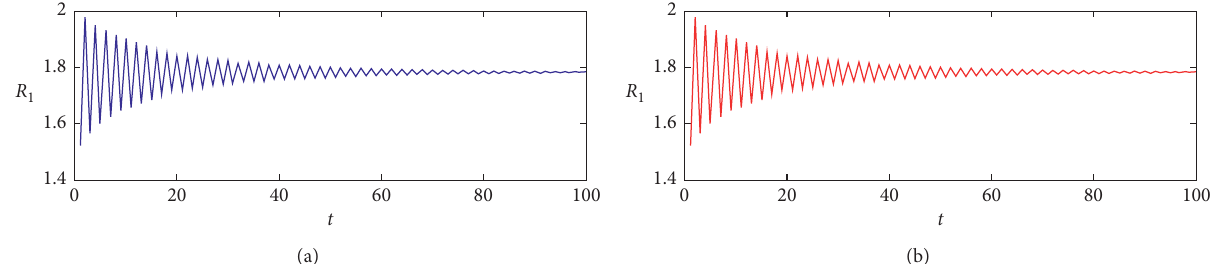
Figure 8: Orbits of R